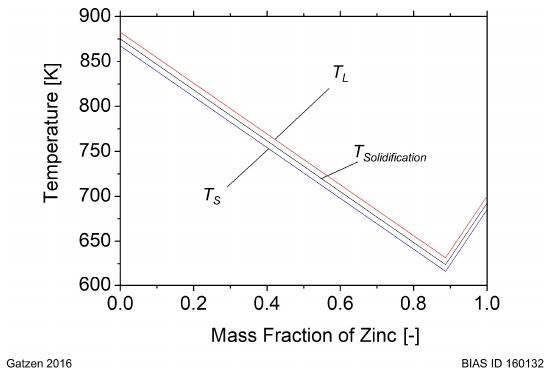
Figure 2. Solidification temperature (cid:1846) (cid:3020)(cid:3042)(cid:3039)(cid:3036)(cid:3031)(cid:3036)(cid:3033)(cid:3036)(cid:3030)(cid:3028)(cid:3047)(cid:3036)(cid:3042)(cid:3041) , liquidus temperature (cid:1846) (cid:3013) , and solidus temperature (cid:1846) (cid:3020) used for the simulation.